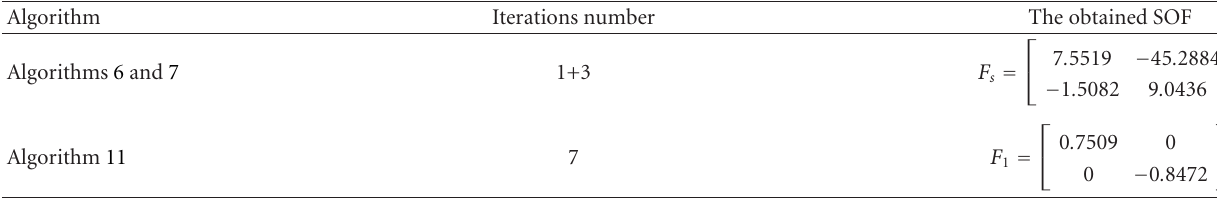
Table 1: A structured SOF admissibility control